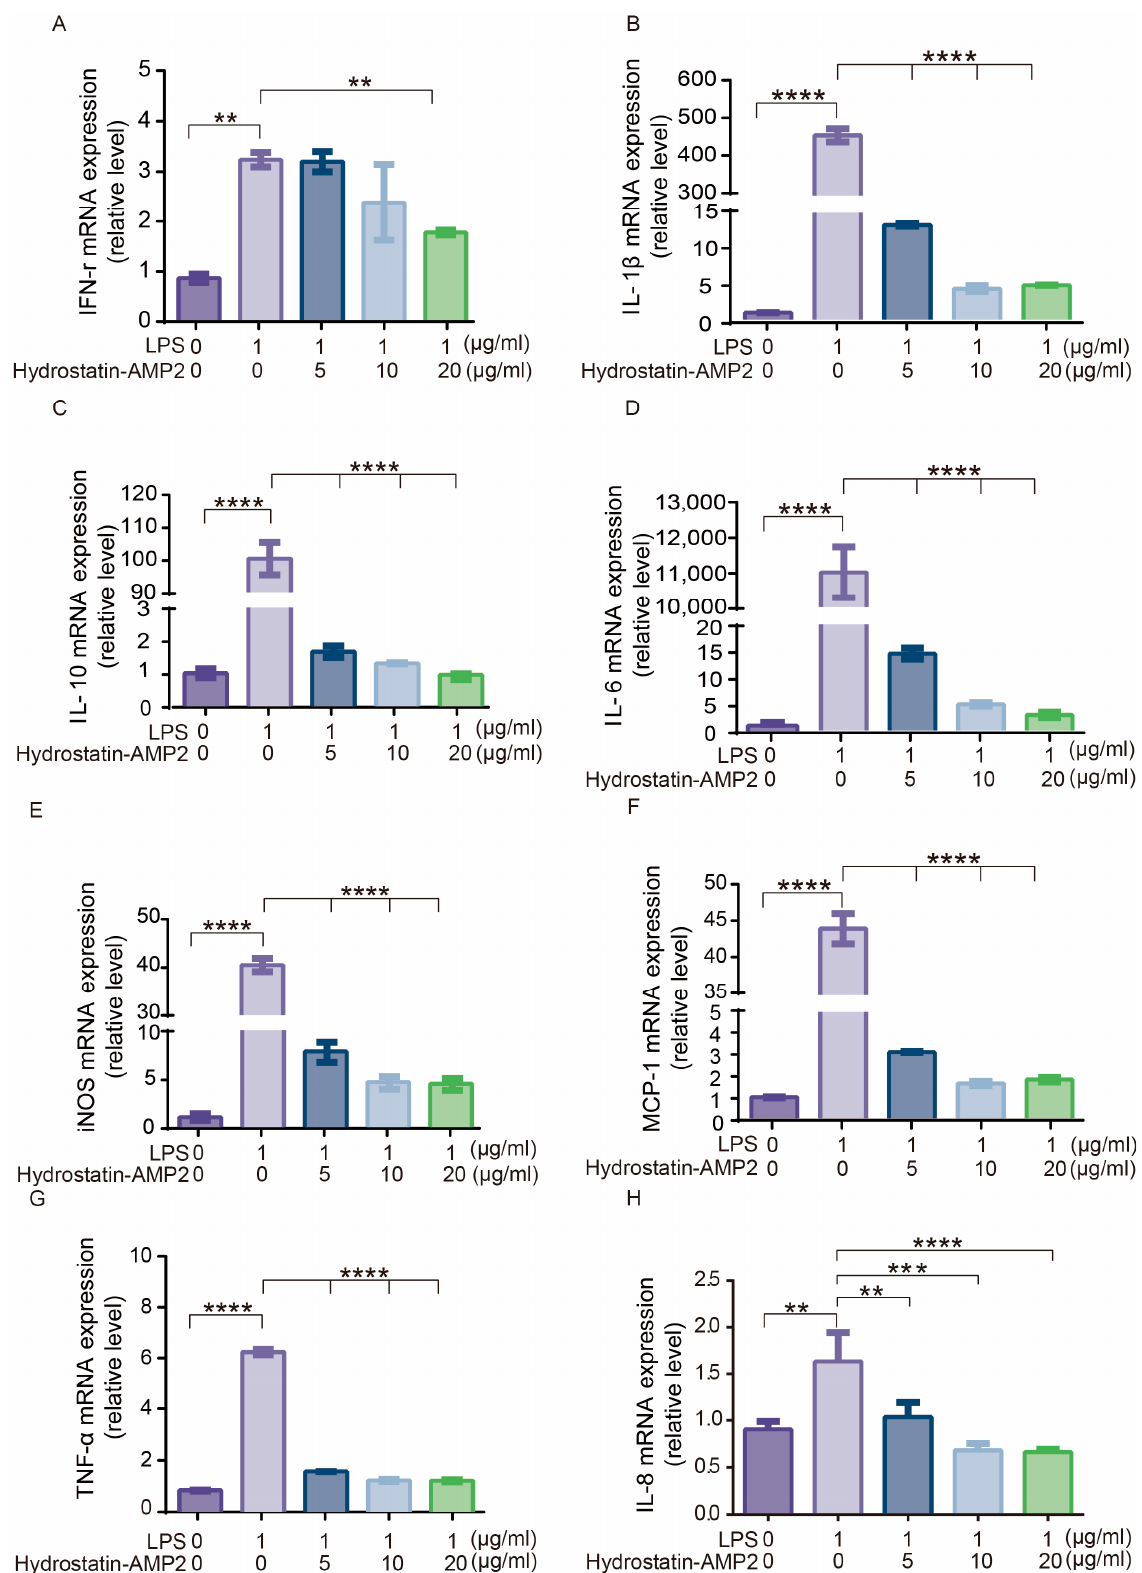
Figure 7. Effects of Hydrostatin-AMP2 on LPS-induced expression of pro-inflammatory factors. ( A – H ) Relative mRNA expression level of IFN- γ , IL-1 β , IL-10, IL-6, iNOS, MCP-1, TNF- α and IL-8. Data represent mean ± SD values of three independent experiments performed in triplicate. **, p < 0.01; ***, p < 0.001; ****, p < 0.0001 (significantly different compared with the model group).